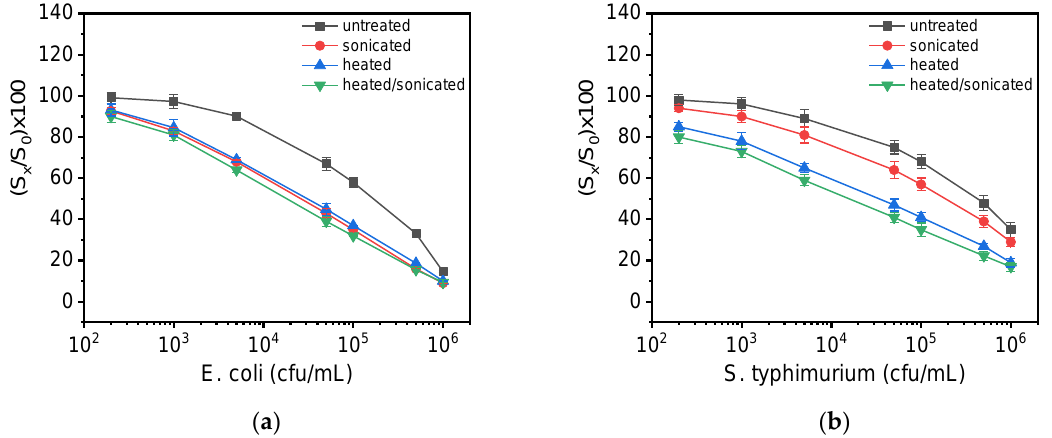
Figure 4. Calibration curves obtained for ( a ) E. coli and ( b ) S. typhimurium with calibrators prepared using live untreated (grey squares), heat-treated (blue triangles), ultra-sonicated (red circles) or heat-treated and ultra-sonicated bacteria (green triangles). Each point is the mean value of three measurements. Error bars correspond to ±SD.